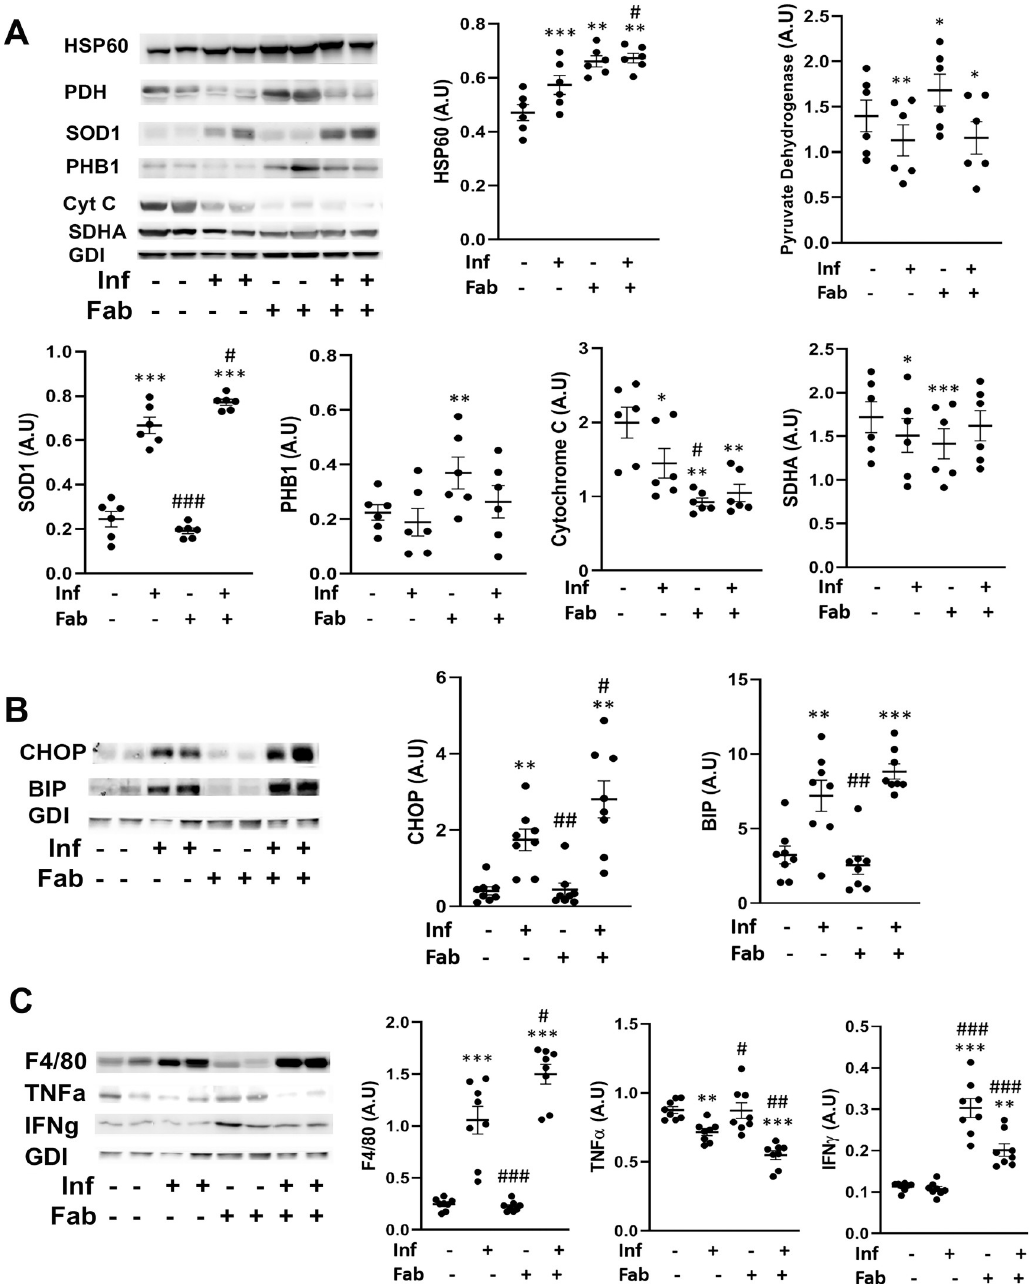
Fig 7. Fat ablation on mitochondrial dysfunction, ER stress and inflammation in the hearts of chronic CD mice. A. Immunoblot analysis of (A) markers of mitochondrial function (cytochrome C, pyruvate dehydrogenase, SDHA, HSP60 and SOD1), (B) markers of ER stress (BIP and CHOP) and (C) markers of infiltration of macrophage (F4/80) and cytokines (TNF α and IFN γ ) in the hearts of indicated mice (infected or uninfected mice, fat-ablated (Fab +) or fat-unablated (Fab -) n = 8). The change in protein levels were normalized to the levels of Guanosine nucleotide dissociation inhibitor (GDI) and plotted column scatter graph. The error bars represent SEM. A.U. indicates arbitrary unit. � p � 0.05, �� p � 0.01 or ��� p � 0.001 compared with uninfected fat-unablated. # p � 0.05, ## p � 0.01 or ### p � 0.001 compared with infected fat-unablated.